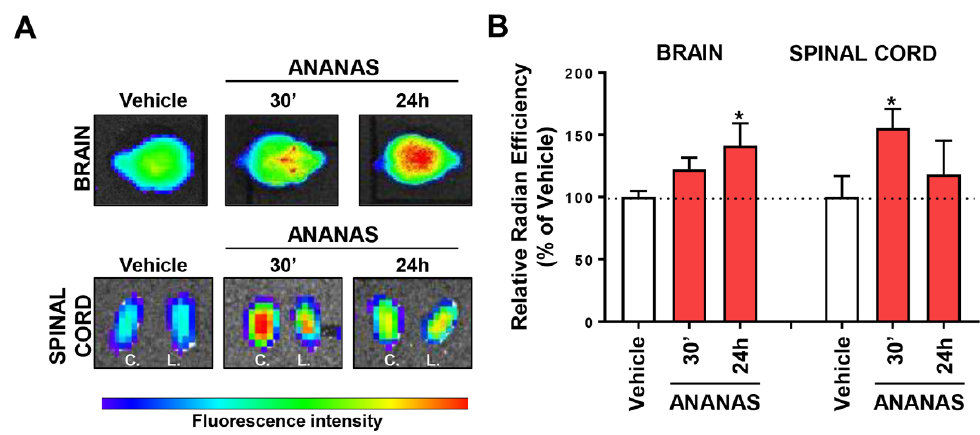
Figure 5. Ex vivo biodistribution in SOD1 G93A mice. ( A , B ) Ex vivo optical analysis of brain and spinal cord from SOD1 G93A mice treated with saline (Vehicle) or with ANANAS and sacrificed with intracardial perfusion 30 min and 24 h after the treatment. ( A ) Representative images of brain and cervical (C.), lumbar (L.), spinal cord. ( B ) Quantification of ex vivo optical imaging signal in brain and spinal cord. Dotted lines indicate the mean of vehicle. Data (mean ± SD; n = three or four in each experimental group) indicates the relative radian efficiency and are expressed as percentages of the respective vehicle. * p < 0.05 versus vehicle, by one-way ANOVA, Tukey’s post hoc test. For longitudinal tracking, ANANAS were labelled with the fluorophore